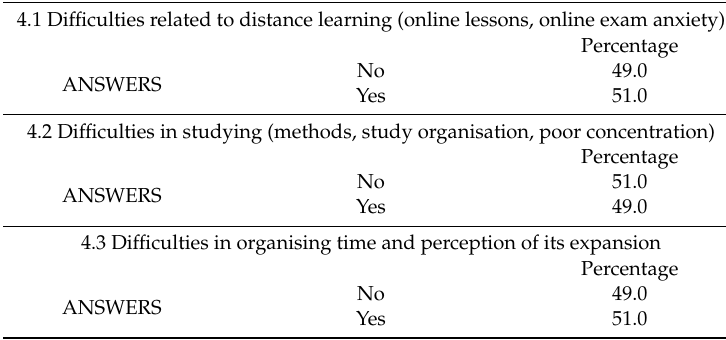
Table 4. Area 4: distance learning / study di ffi culties and related